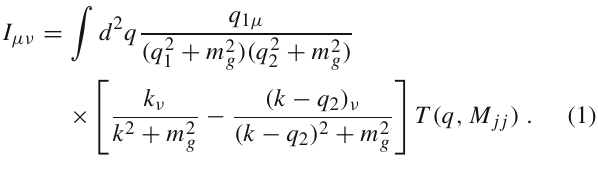
μν and β carried by the active gluon in hard Pomeron and by the parton in soft Pomeron are shown in b . Lorentz indices of the partons incoming the hard matrix elements are marked in